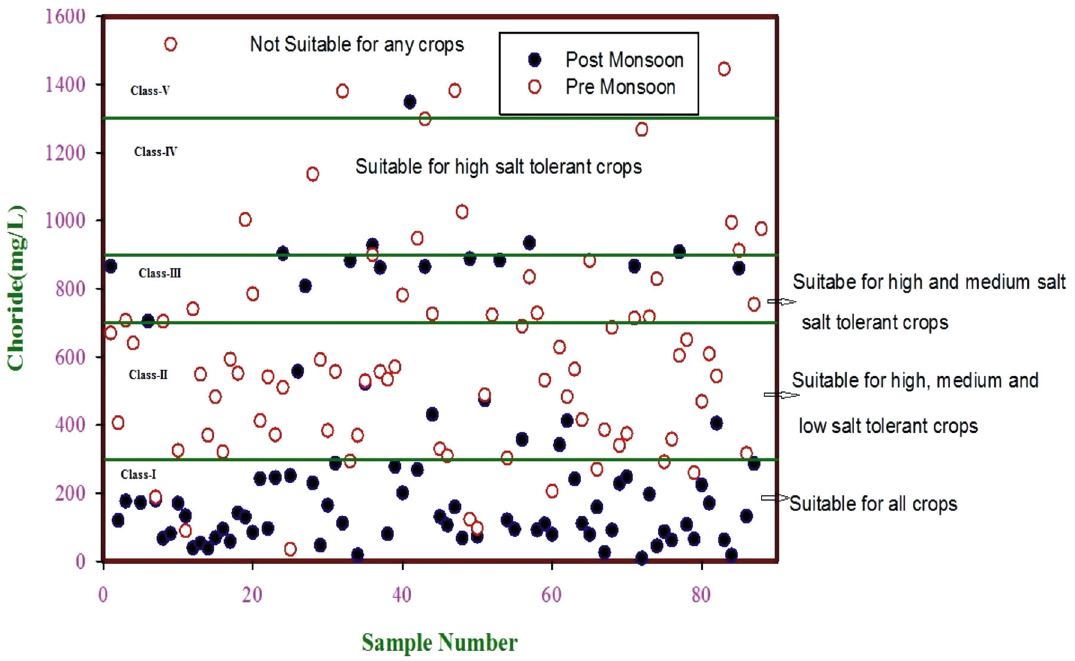
Fig. 19 Chlorinity index for water